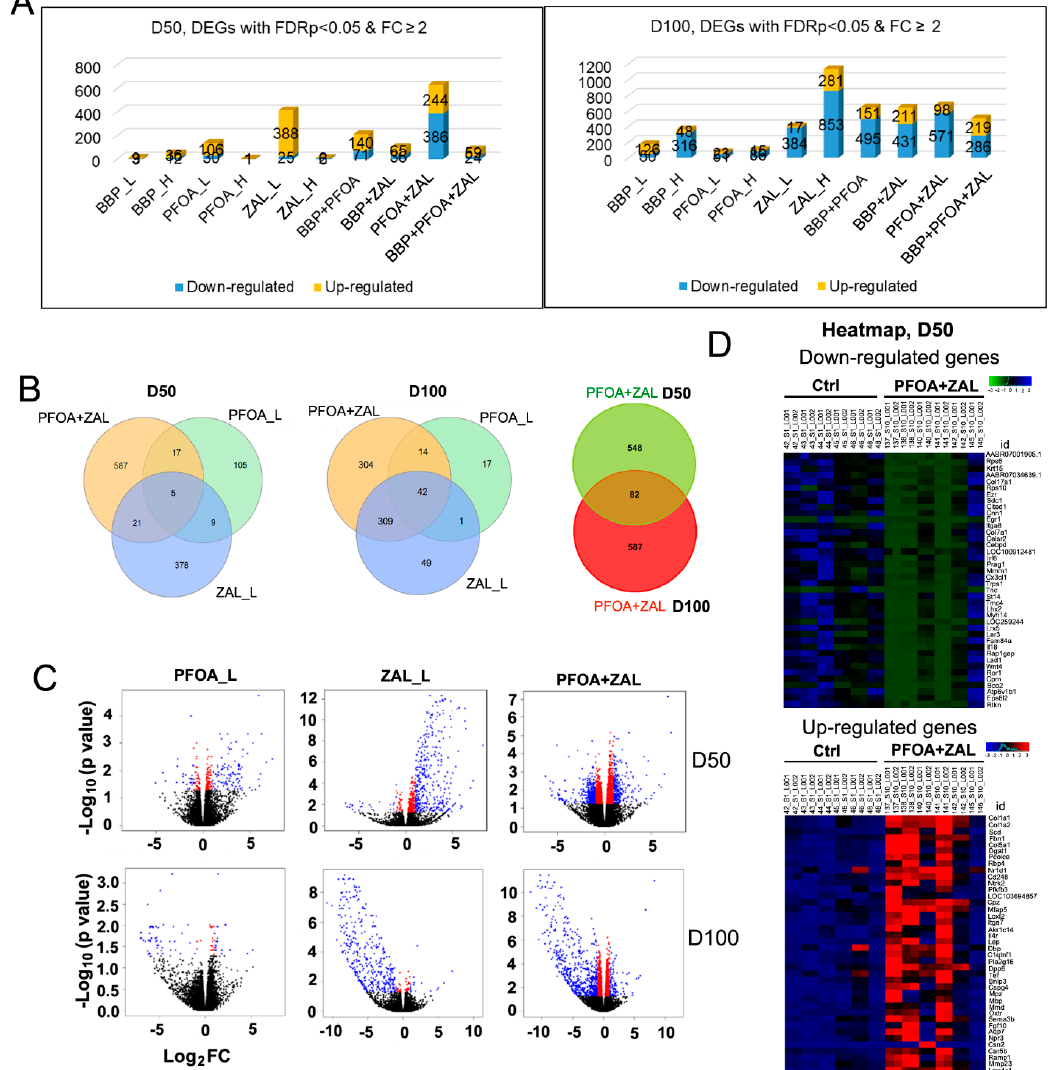
Figure 3. Transcriptomic changes in the rat mammary glands caused by BBP, PFOA, and ZAL exposure: ( A ) The number of DEGs induced by BBP, PFOA, and ZAL -alone or in combination- at D50 and D100; n = 6 glands per group. ( B ) Venn diagram representing the number of DEGs in each treatment (FC ≥ 2) and the common genes between/among the treatments. ( C ) Volcano plots of pairwise comparisons, displaying the relation between fold change and significance between the two groups, using a scatterplot view. The y -axis shows the negative log 10 of FDR-adjusted p -values ( − log 10 ( p value)); a higher value indicates greater significance. The x -axis shows the difference in expression between the treated group and Ctrl, presented in log 2 fold change (log 2 FC). Each gene is represented by one dot in the graph; red dots represent genes showing statistically significant changes (FDRp < 0.05) and log 2 FC < 1, blue dots represent genes showing FDRp < 0.05 and log 2 FC ≥ 1 (considered as DEGs), and black dots represent non-significant genes. ( D ) Heatmaps of the 40 top down- or upregulated DEGs (FC ≥ 2.0) by PFOA + ZAL compared to Ctrl at D50. Color code for downregulated genes: blue for overexpression, black for intermediate expression, and green for underexpression. Color code for upregulated genes: red for overexpression, black for intermediate expression, and blue for underexpression; n = 6 mammary gland samples per group, and each sample was sequenced